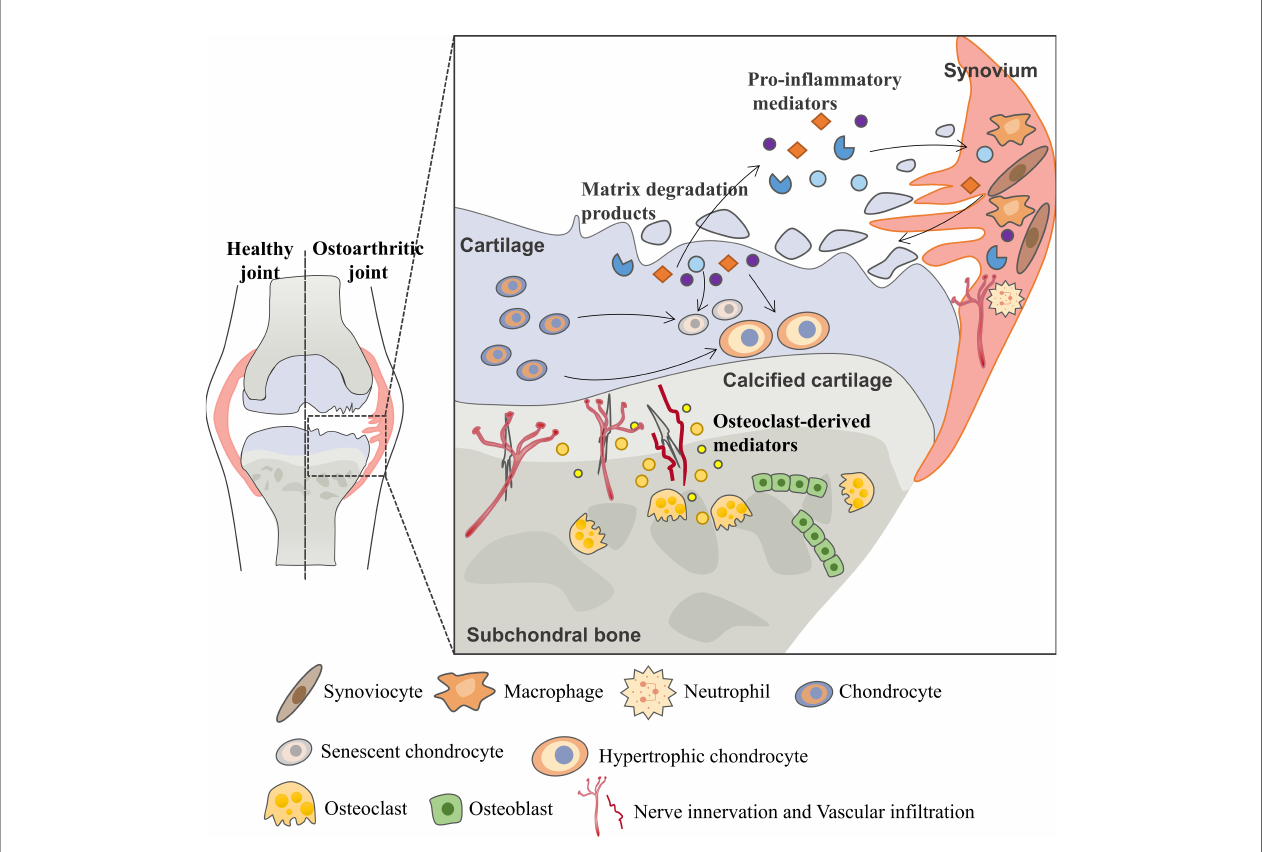
FIGURE 1 | Vicious cycle during OA progression. During the osteoarthritis process, the imbalance between the anabolic activities and catabolic activities of cartilage ECM-degrading enzymes (aggrecanases and matrix metalloproteinases) leads to further extracellular matrix degradation. Products from matrix degradation act on the synovium to induce in fl ammation and the release of pro-in fl ammatory mediators (cytokines, chemokines, etc.) that feedback on chondrocyte and cause cartilage breakdown. This process also promotes phenotypic alterations of chondrocytes and leads to chondrocytes hypertrophy and senescence. In the subchondral bone, osteoclasts are activated in response to abnormal mechanical loading and pro-in fl ammatory mediators, resulting in bone resorption and release of osteoclast-derived mediators which regulate sensory innervation and vascular invasion into the osteochondral junction. This process also correlates with OA pain. Abnormal bone remodeling is then followed by increased bone formation, leading to subchondral bone sclerosis. The homeostatic imbalance of the osteochondral unit increases cartilage susceptibility to disruption and contributes to OA pathological